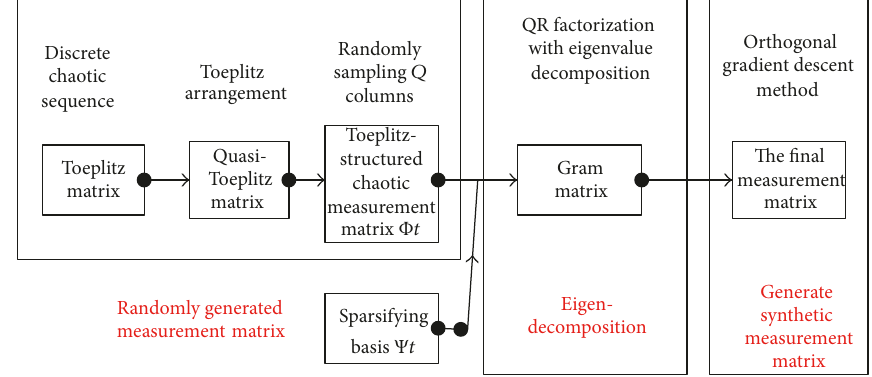
Figure 4: The improved scheme by different